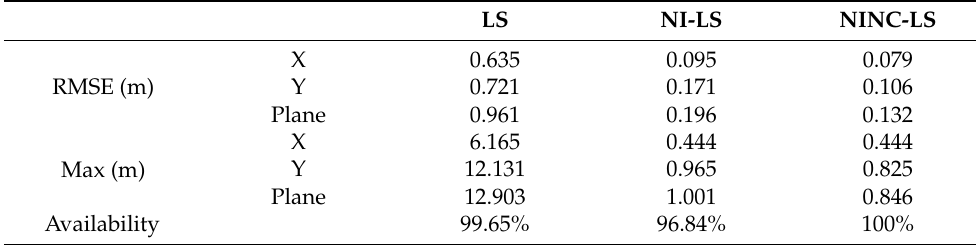
Figure 9. Based on the threshold judgment principle, the method corrects some of the NLOS measurements to obtain the corrected measurements. Table 2 shows that the